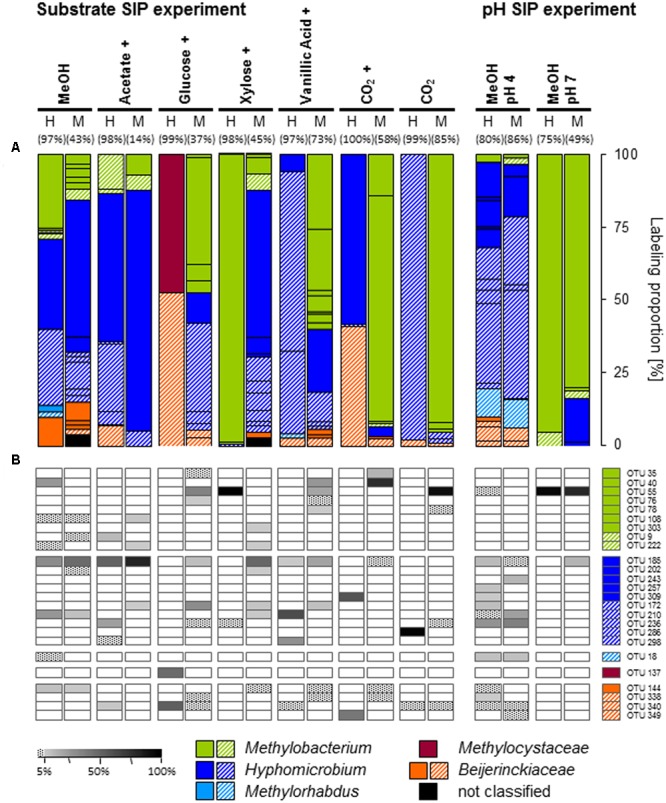
Labeling proportions and identities of mxaF phylotypes in the ‘heavy’ and ‘middle’ fractions of all labeled mxaF phylotypes in substrate or pH treatments (A) and the relative frequencies of labeled phylotypes (i.e., gray shades, ‘labeling proportion’ >5%; dotted, ‘labeling proportion’ <5%) (B). Cross, additional [12C]-methanol supplementation in the substrate SIP experiment. Equal colors, the same family affiliation. Shading, ambiguous affiliation (i.e., sequence identity with BLASTn <90% and an ambiguous position in the phylogenetic tree). ‘H’ and ’M,’ ‘heavy’ and ‘middle’ fractions, respectively. Values in brackets, contribution of labeled OTUs to the total number of sequences. The ‘labeling proportions’ are indicators for the relative importance of different taxa assimilating the supplemented 13C (directly or indirectly). More detailed taxonomic information can be found in Supplementary Table S15.